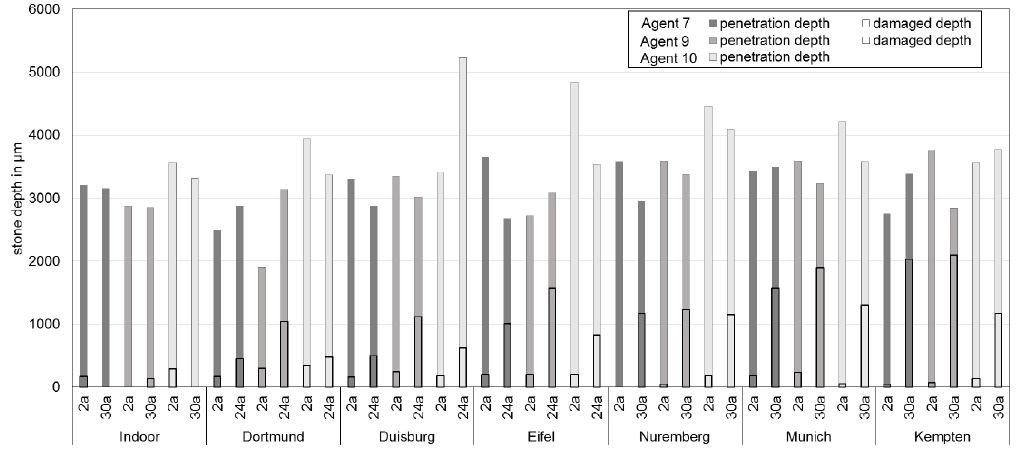
Figure 16. Comparison of the penetration depth of agents 7, 9 and 10 applied on OKS with the damaged depth calculated with Equation (5) (depth 0 = surface of the stone).